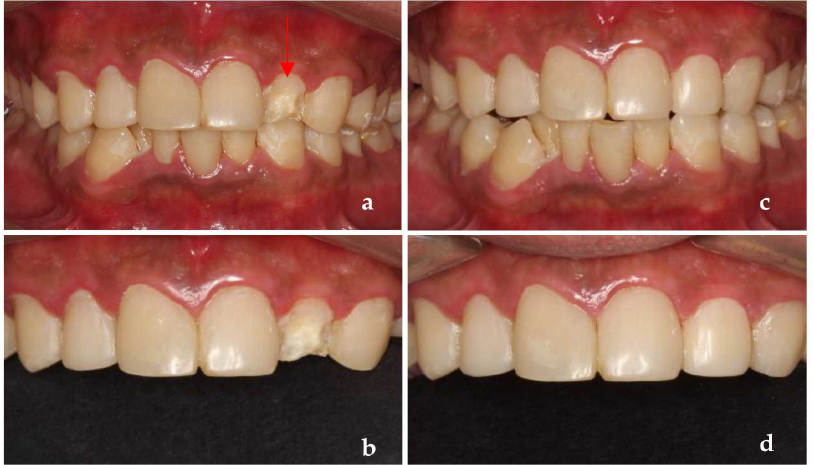
Figure 5. ( a , b ) One year after treatment; ( c , d ) After the dentist dealt with the new problem in time.